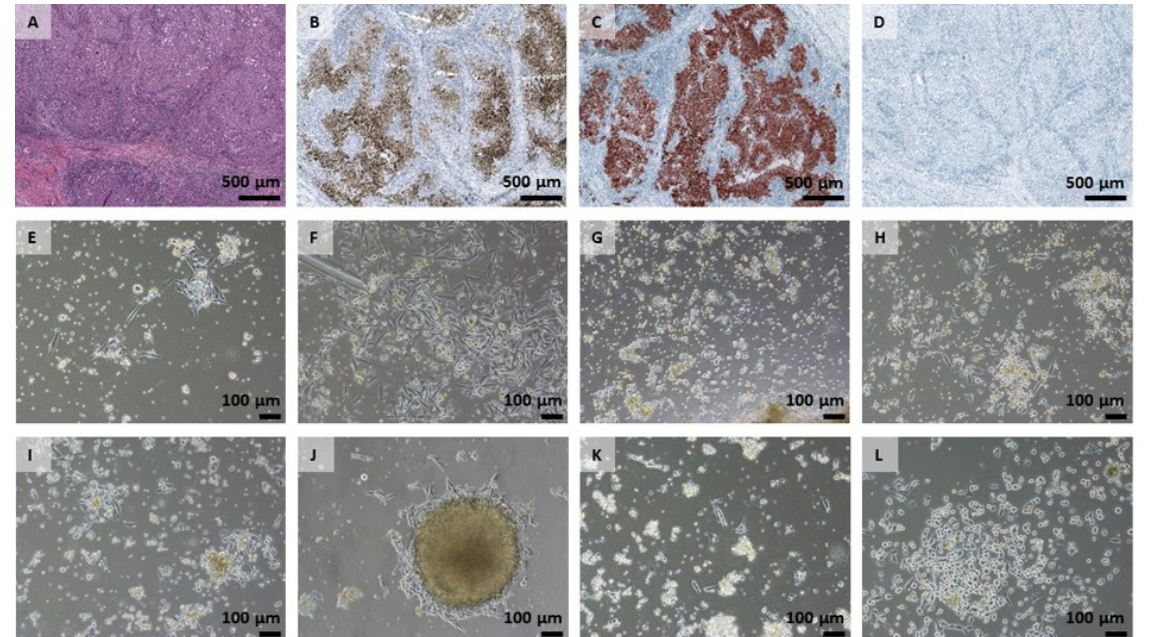
Figure 2. IHC of primary tumor tissue and morphological overview of cell growth. A – D : Formalin fixed, paraffin embedded (FFPE) and stained tissue sections of the primary tumor tissue. A : H&E, B : HMB45; C : Melan-A; D : Tyrosinase. Stained tissue sections were scanned with a PANNORAMIC ® 1000 (3DHISTECH, Budapest, Hungary) and pictures were analysed using CaseViewer 2.4 software (3DHISTECH, Budapest, Hungary). E – L : Morphological presentation of the individual cultures observed over time; representative areas are illustrated. E : MUG Mel3 PF (day six); F : MUG Mel3 PF (day eight); G : MUG Mel3 Ph (day six); H : MUG Mel3 Ph (day eight); I : MUG Mel3 NPF (day six); J : MUG Mel3 NPF (day eight); K : MUG Mel3 NPh (day six); L : MUG Mel3 NPh (day eight).